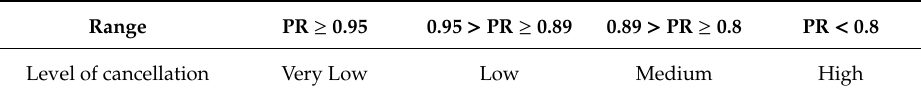
Table 5. Description of the prevailing